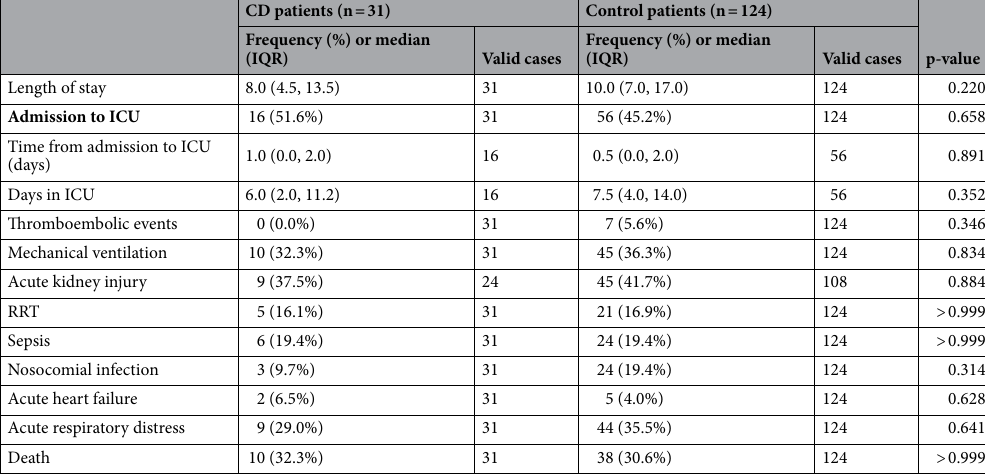
Table 5. Clinical outcomes. CD chagas disease, ICU intensive care unit, IQR interquartile range, RRT renal replacement